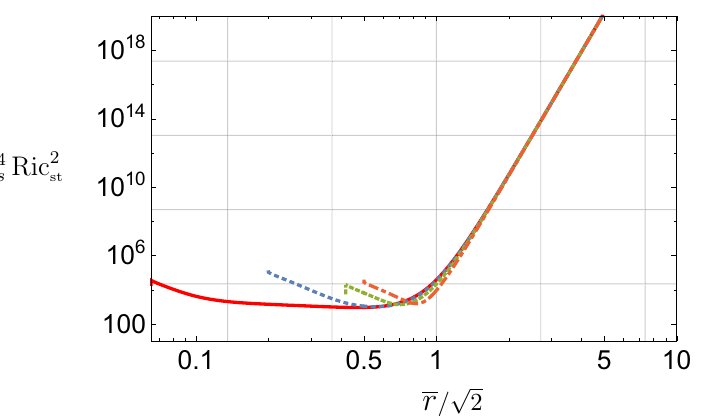
as defined in (3.16). R φ